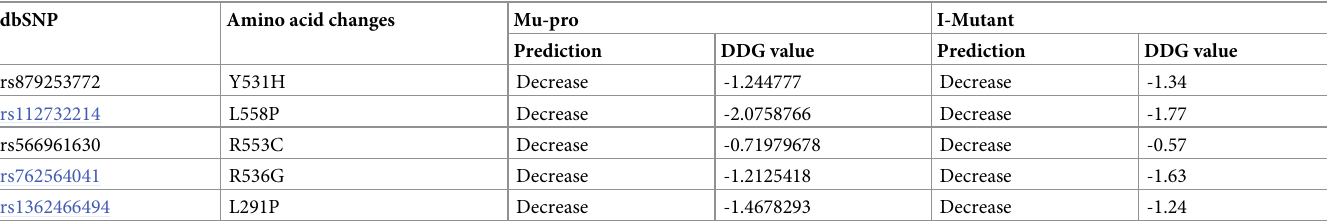
Table 4. Impact of single nucleotide polymorphisms on the stability of protein.